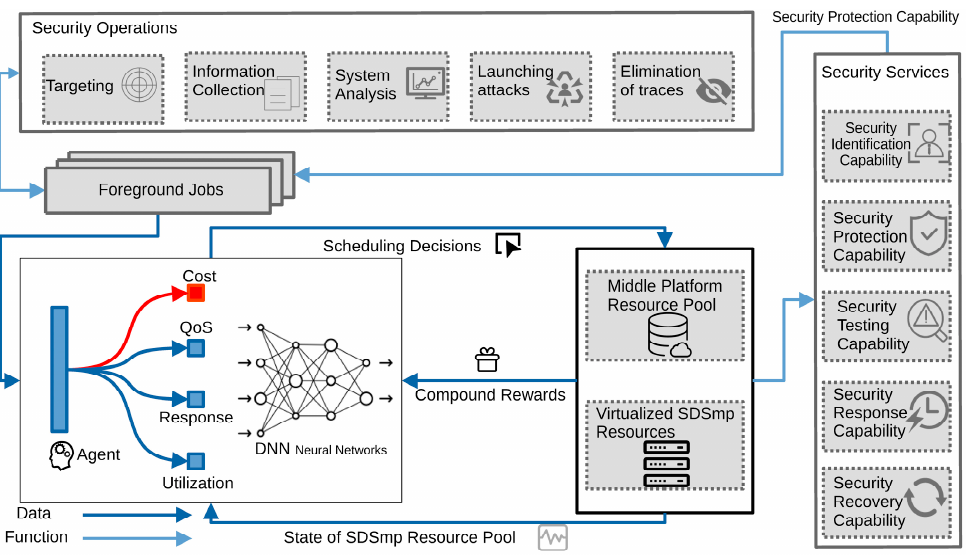
Figure 3. A DRL-based algorithm for real-time cost optimization of the MPC-SDSmp.